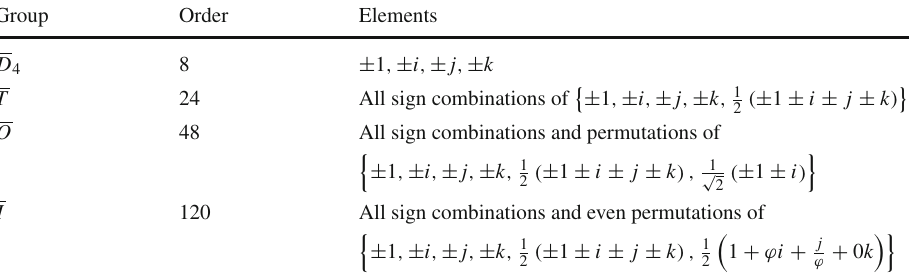
Table 1 Quaternionic representation of D 4 , T , O and I as found in [19], where +√ ϕ = 1 5 denotes the golden 2 ratio